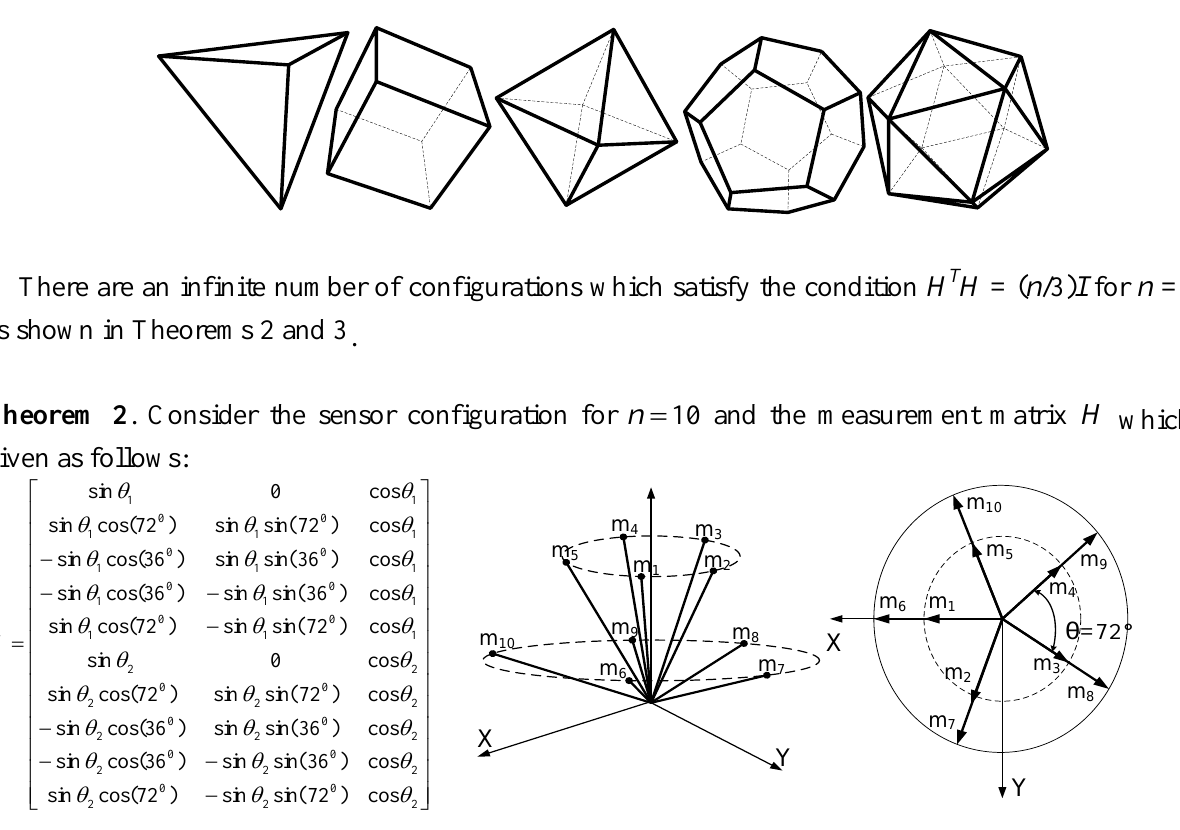
Figure 1. Platonic solids (Regular